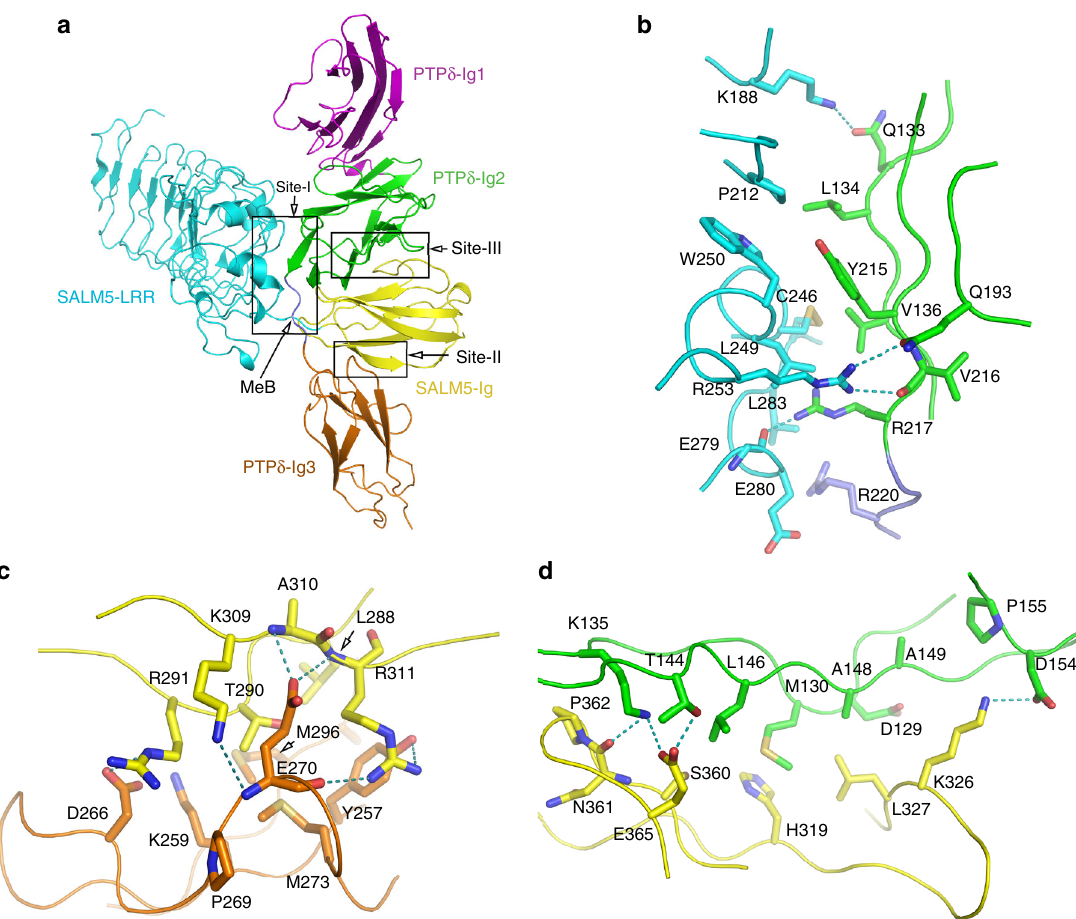
Fig. 3 Recognition mechanism of SALM5 by PTP δ . a Ribbon representation of 1:1 SALM5/PTP δ complex, with the same color code for each domain as Fig. 1a. The complex interface is divided into three sites labeled as site I, II, and III. b – d Close-up views of site I ( b ), II ( c ), and III ( d ). c is relative to a by a 90° rotation along the vertical line. a , b The MeB insert and its residue R220 are colored in